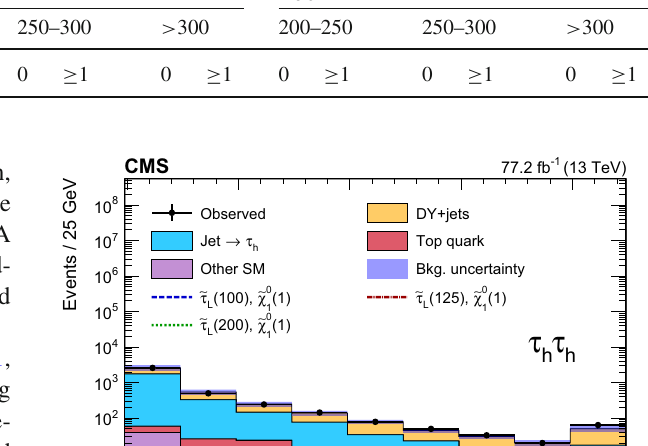
Table 1 Ranges in m T2 , Σ m T , and N j used to define the SRs used in the τ